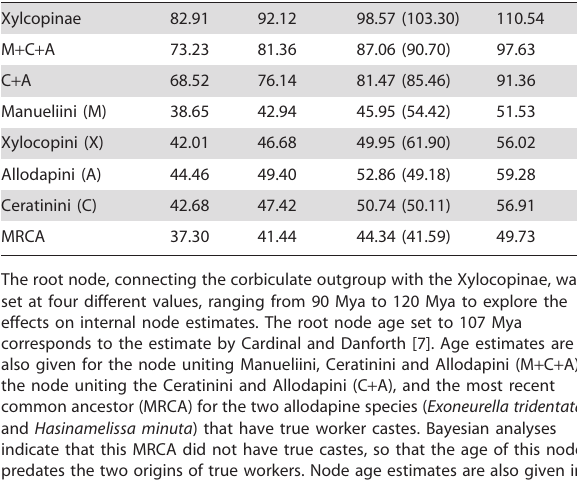
Figure 2. Evolution of sociality in the Xylocopinae. Chronogram of the Xylocopinae based on 70 species from all extant xylocopine tribes. The chronogram was derived from a log normal relaxed clock model in BEAST and posterior probability support for each node is indicated by numbers above branches. Social species are coloured red, solitary species are blue and species where social status are unknown are black. Outgroup clades are indicated by grey branches and the root node, uniting the outgroup and the Xylocopinae, was set at 107 Mya. The two Xylocopinae species known to have true worker castes are indicated by black rectangles. The relative probabilities of social and solitary as states for key internal nodes were estimated using a Bayesian analysis and are summarized as pie charts with the probability of being social (red slices) indicated by italic numbers. For Xylocopini and Ceratinini, which are both monogeneric, we have used the subgeneric rather than generic names.